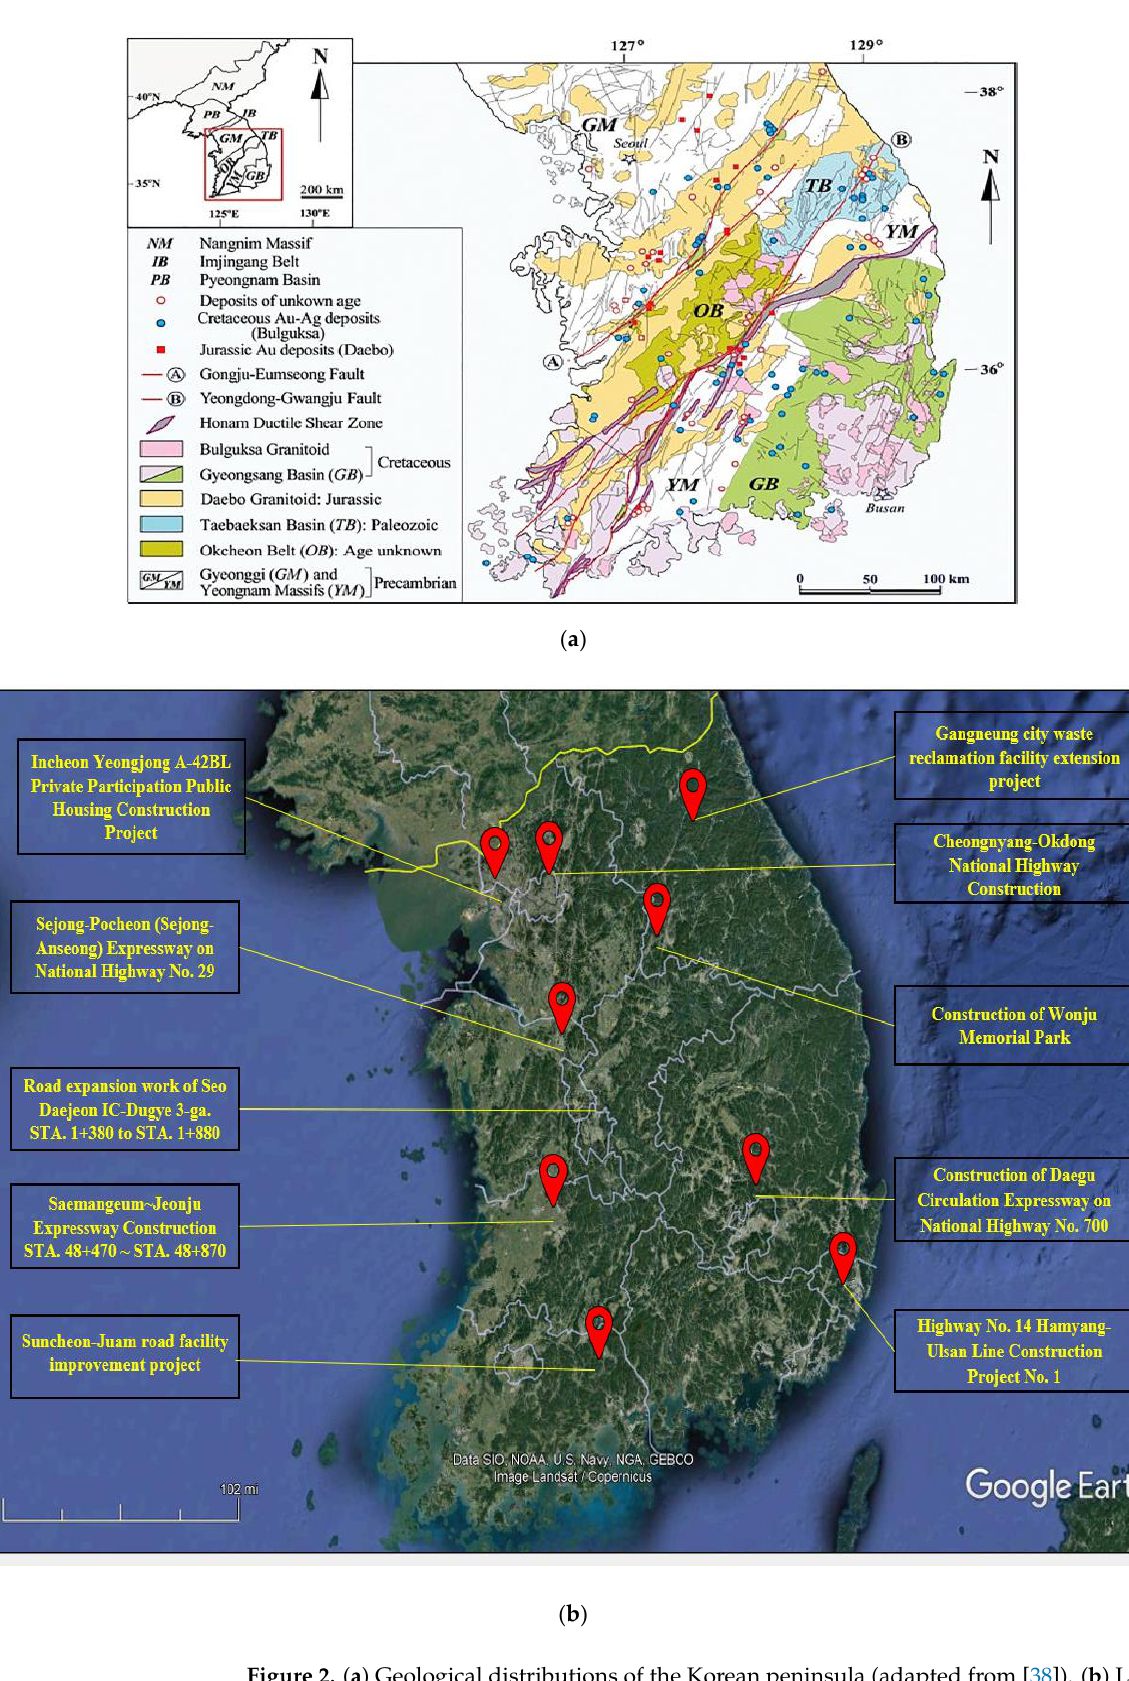
Figure 2. ( a ) Geological distributions of the Korean peninsula (adapted from [38]). ( b ) Location of the construction blasting sites in this